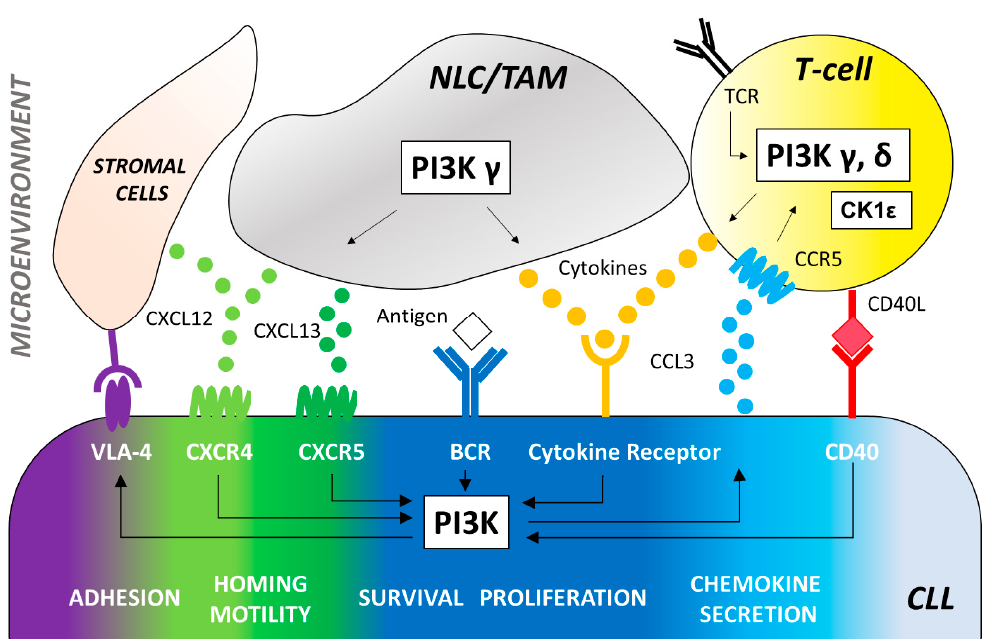
Figure 1. The effector molecule PI3K plays a central role in multiple signaling pathways promoting B-cell development and function. CLL cells depend on signaling via the BCR engagement that induces the activation of PI3K-dependent pathways to increase survival, proliferation, adhesion to stromal cells (via VLA-4), and secretion of chemokines (CCL3 and CCL4). Antigens for the BCR may be expressed by the CLL cells themselves or by other cells in the microenvironment. Key cell types of the tumor microenvironment include: 1. T-cells that can be recruited by CCL3 production and CCR5 receptor binding to provide CD40 ligand (CD40L) and cytokines (IL4, TNF α , IFN γ , CCL3, CCL4) that induce PI3K activation and stimulate the expansion of the malignant CLL clone. PI3K/AKT signaling triggered by the T cell receptor (TCR) plays a critical role in T-cell differentiation, function, and immune tolerance. PI3K δ controls the activity of regulatory T-cells (Tregs) resulting in enhanced anti-tumoral immune functions which may contribute to the activity and toxicity of PI3K δ inhibitors in CLL therapy. Impairment of Treg function by PI3K δ inhibition can be counteracted with CK1 ε modulation. 2. Myeloid-derived nurse-like cells (NLC) and tumor-associated macrophages (TAM) that secrete cytokines and chemokines, such as CXCL12 and CXCL13, which bind to CXCR4 and CXCR5 on CLL cells. PI3K δ is a central integrator of signals